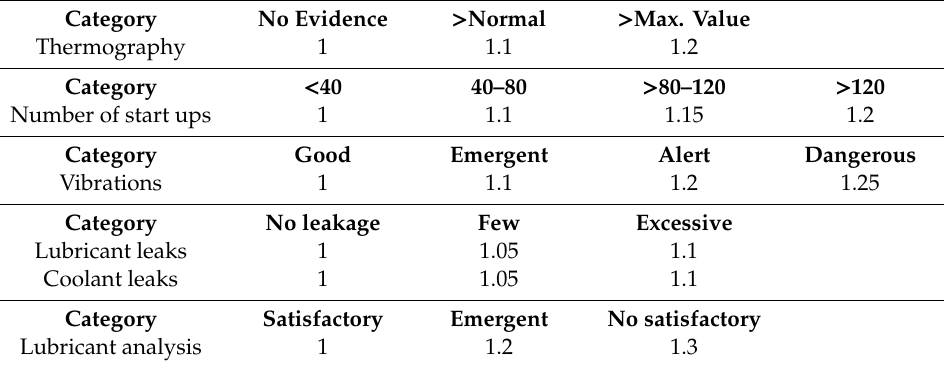
Table 7. Health Modifiers.